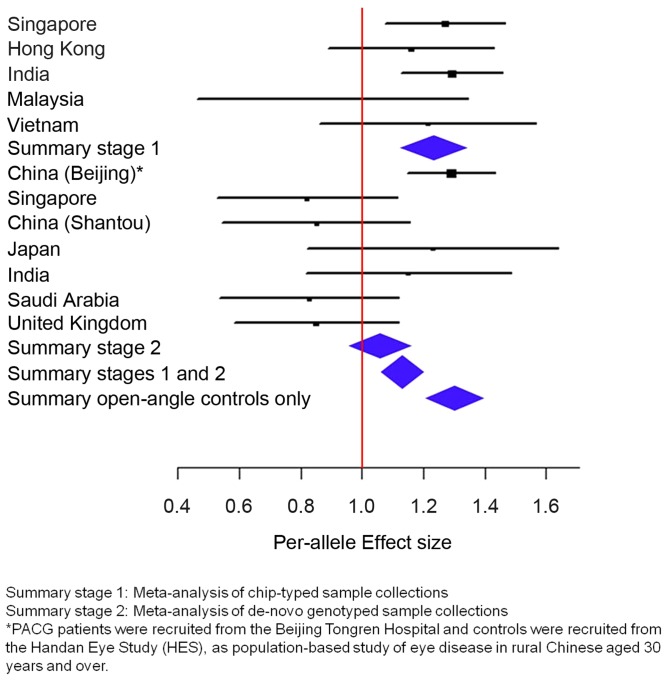
Association analysis between ABCC5 rs1401999 and susceptibility to primary angle closure glaucoma (PACG).The PACG sample collections have been described elsewhere [6]. The vertical line represents a per-allele odds ratio of 1.00. The oblongs represent point estimates (referring to the per-allele odds ratio), with the height of the oblongs inversely proportional to the standard error of the point estimates. Horizontal lines indicate the 95% confidence interval for each point estimate. Meta-analyses of samples are reflected by blue diamonds. The width of the diamonds indicates their 95% confidence intervals. All point estimates in Stage 1 have been adjusted for the top axes of genetic stratification using logistic regression.